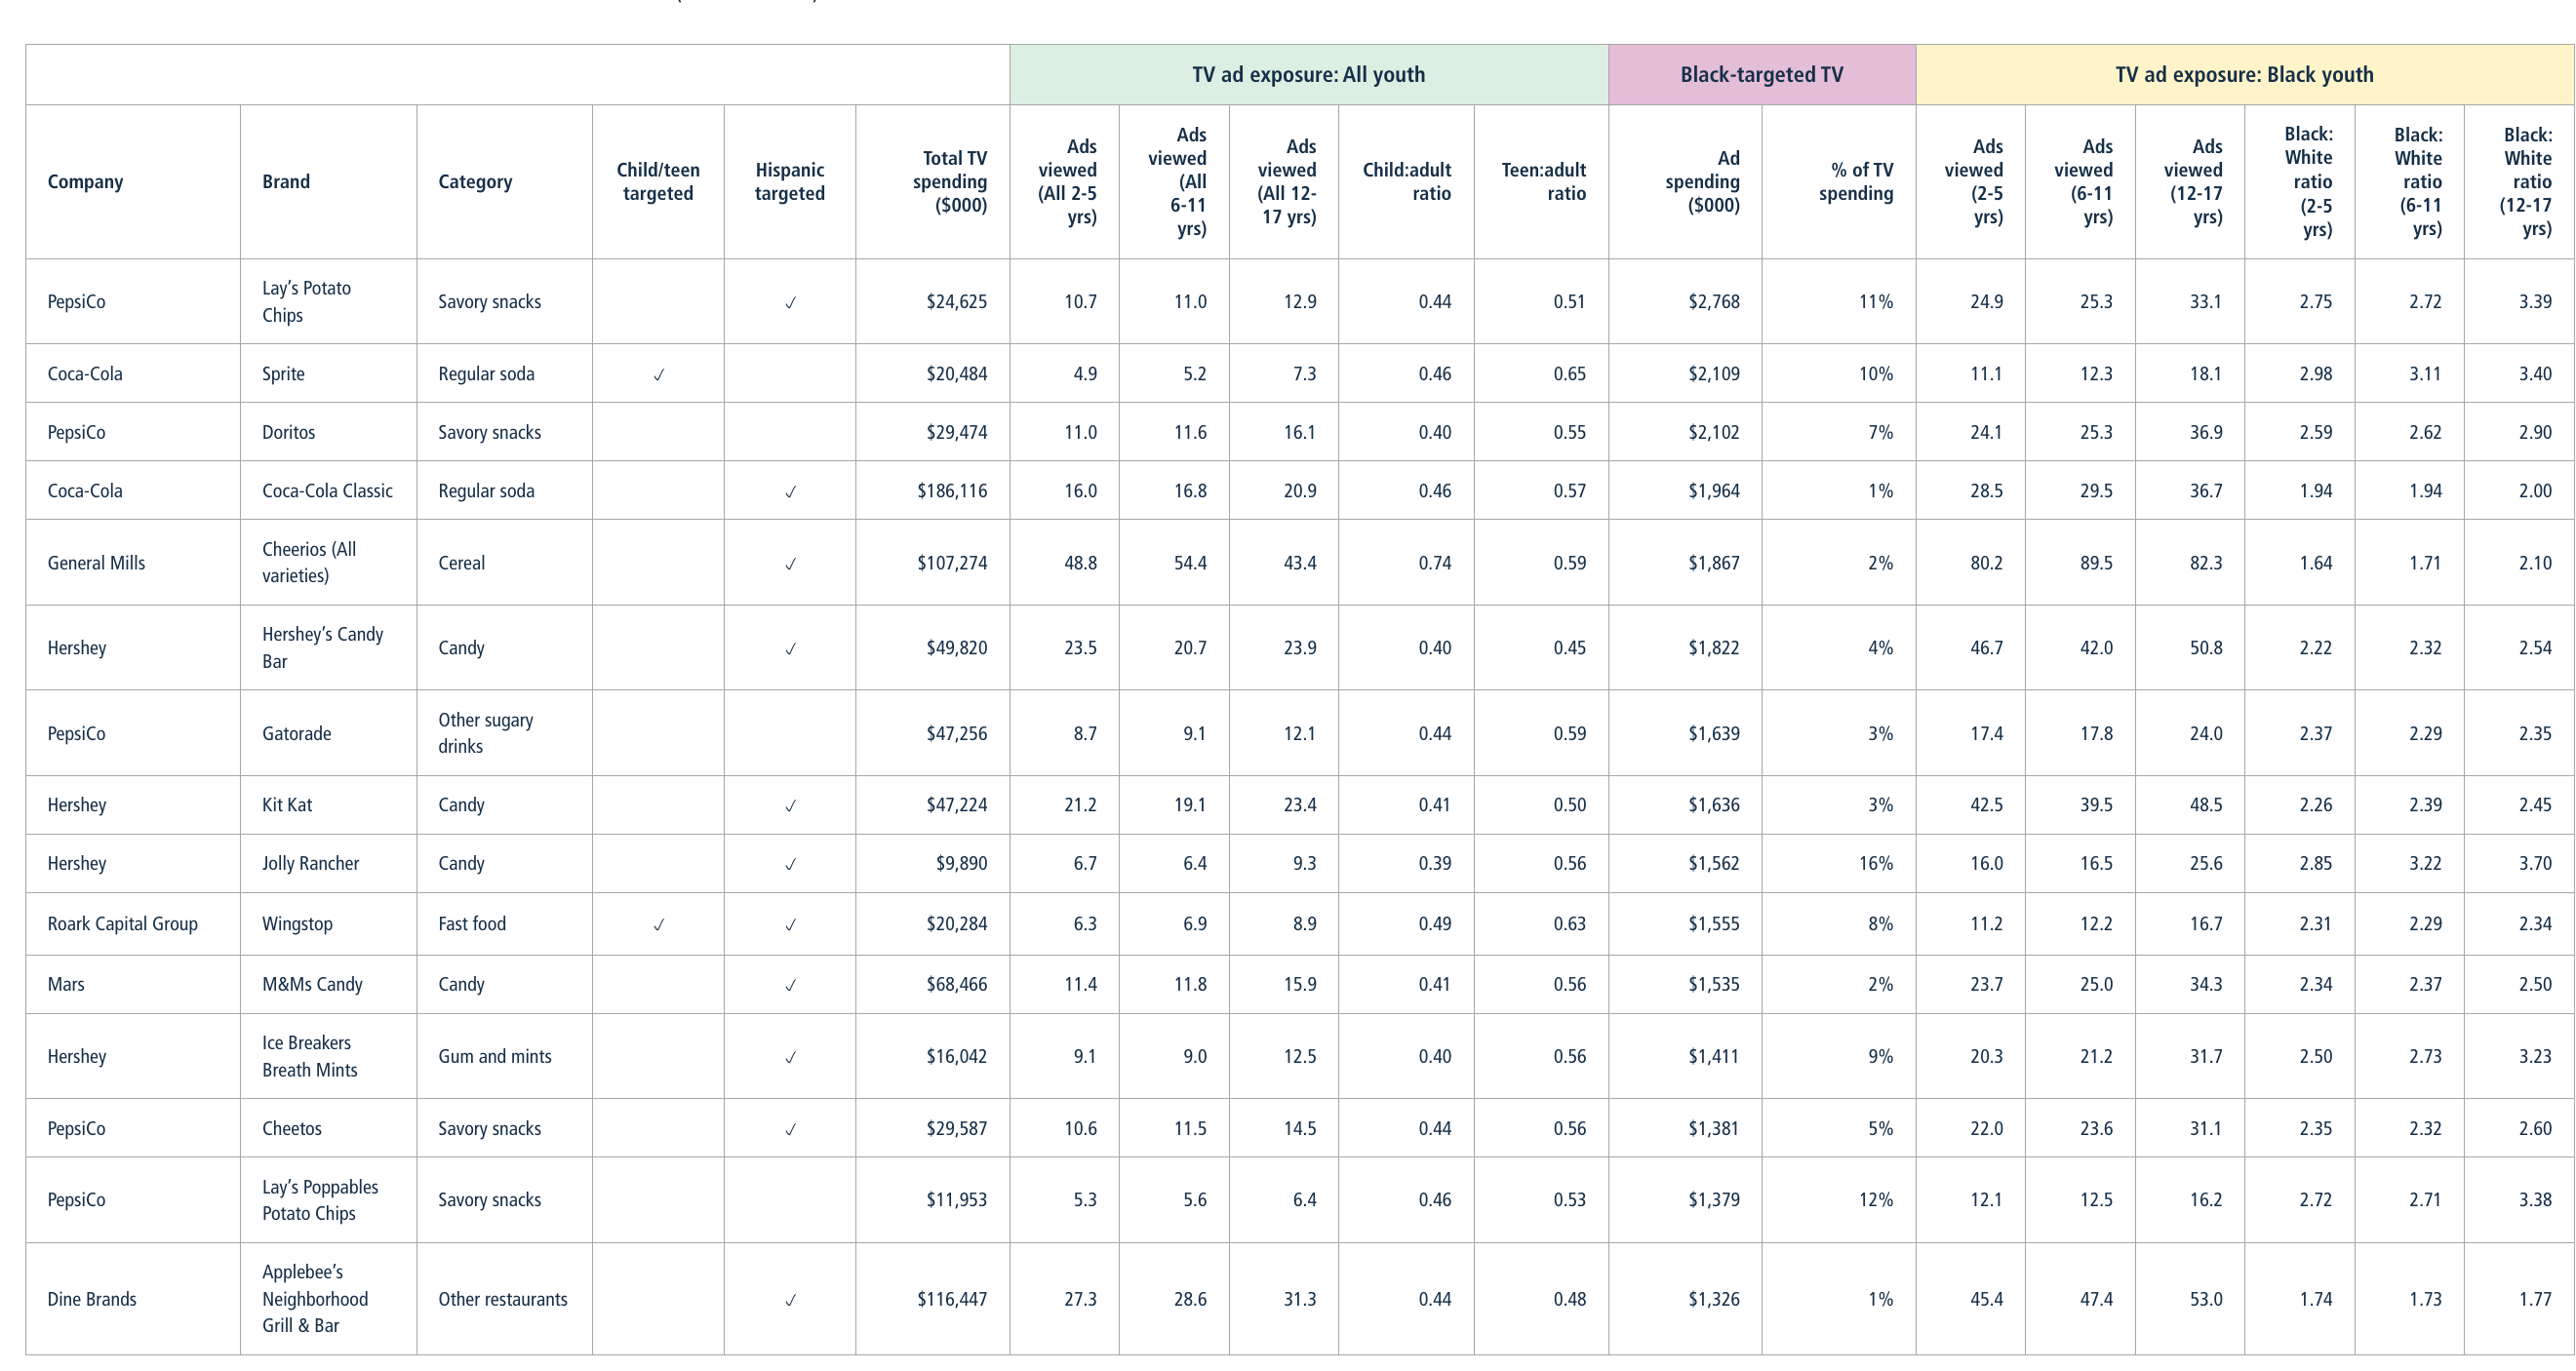
TABLE 3. BRANDS TARGETED TO BLACK CONSUMERS